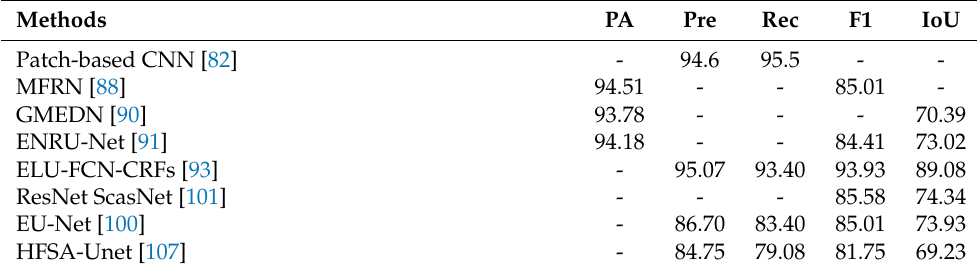
Table 2. Results on Massachusetts Building Dataset (%).